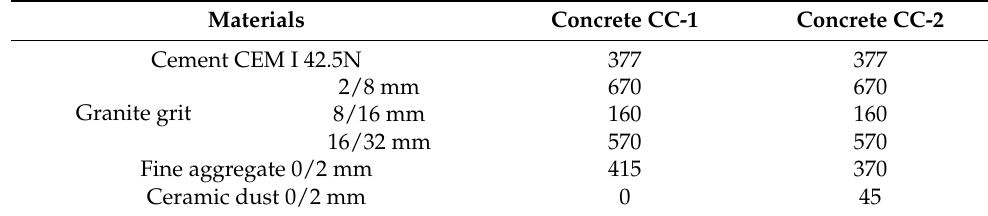
Table 5. Material composition of mixes of series CC-1 and